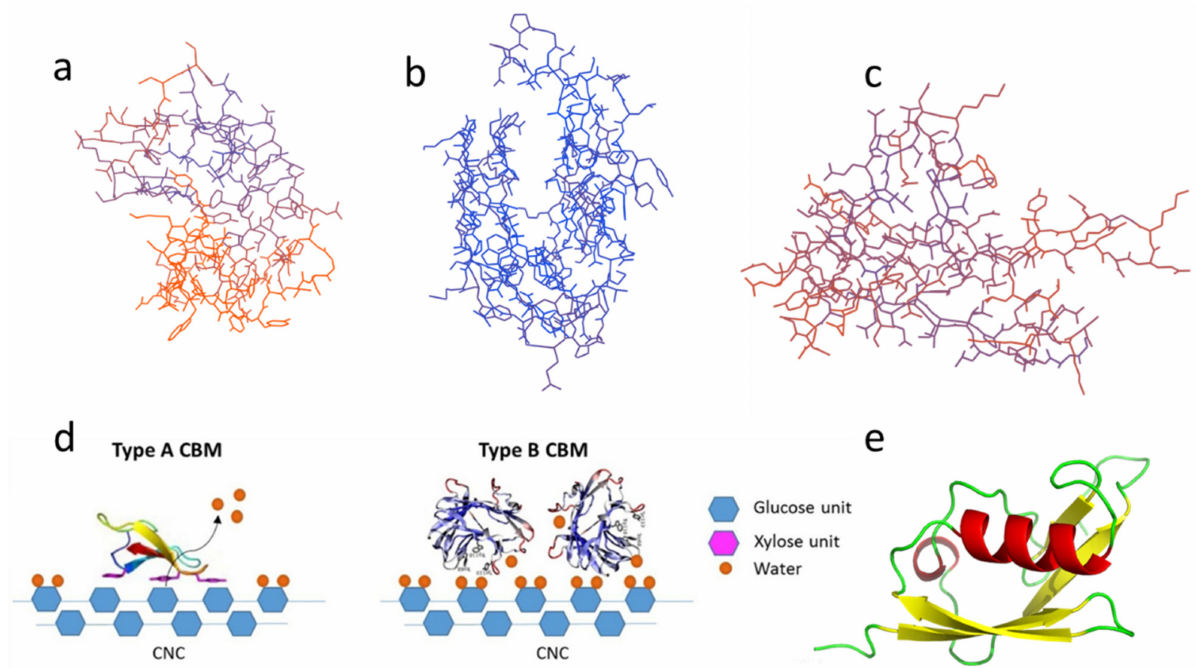
Figure 1. Different types of CBM: ( a ) Type-A, CBM3; ( b ) Type-B, CBM4; ( c ) Type-C, CBM9; ( d ) Schematic of binding of type-A (left) and type-B (right) CBMs on nanocrystalline cellulose (CNC) reprinted from Ref [53] with permission from Elsevier; ( e ) Type-A CBM1 with SUMO solubilizing label. The above structure diagrams are drawn using the base sequences from Table 1 through the Swiss model and